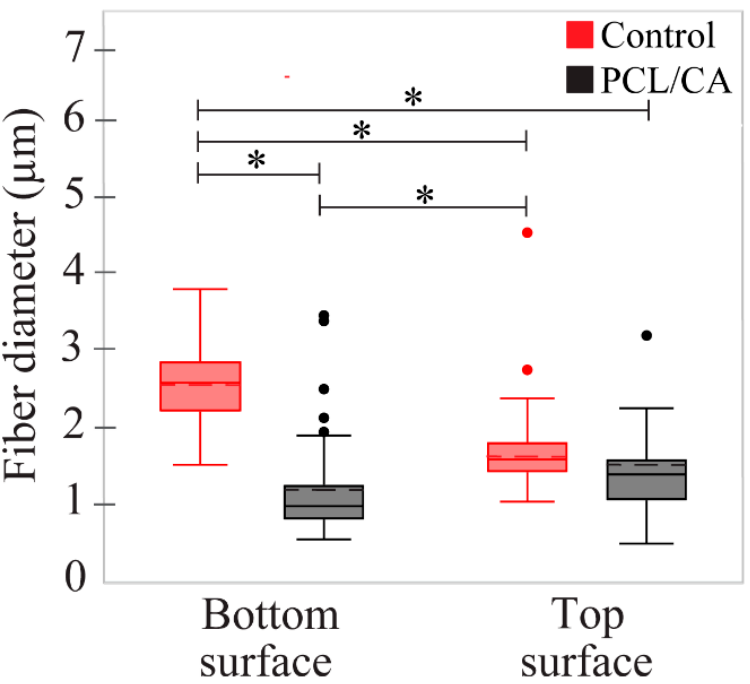
Figure 4. Statistical results of the fiber diameter at the top and bottom surfaces of the control and PCL/CA scaffolds. The dashed lines inside the boxes represent the means of each dataset. (*) Indicates a statistically significant difference with a confidence level of 95% ( p < 0.05).